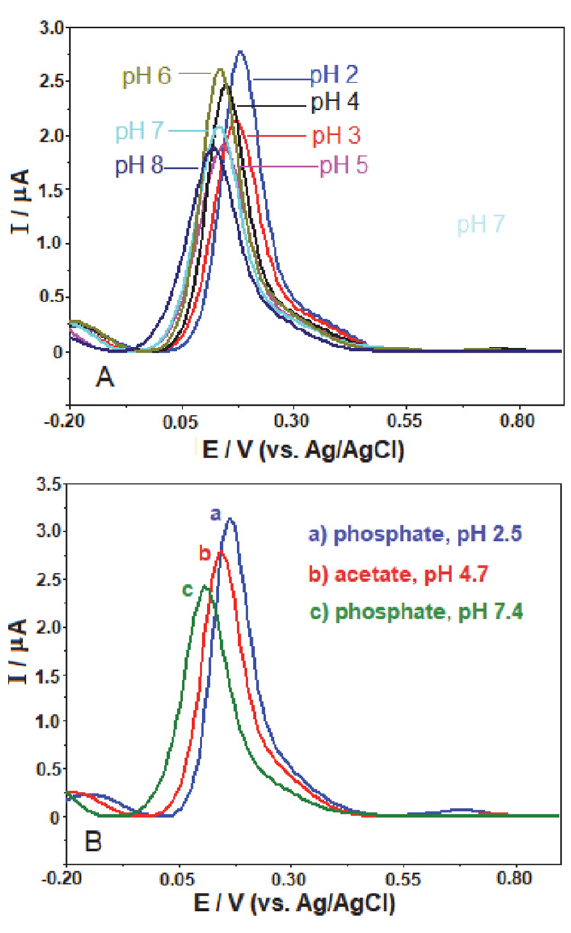
Figure 4. SW voltammograms of 0.1 mM lawsone solutions in Brit- ton-Robinson buffer pH 2.0–8.0 (A), and in various supporting electrolytes (B). Other operating conditions as indicated in Figure 3.